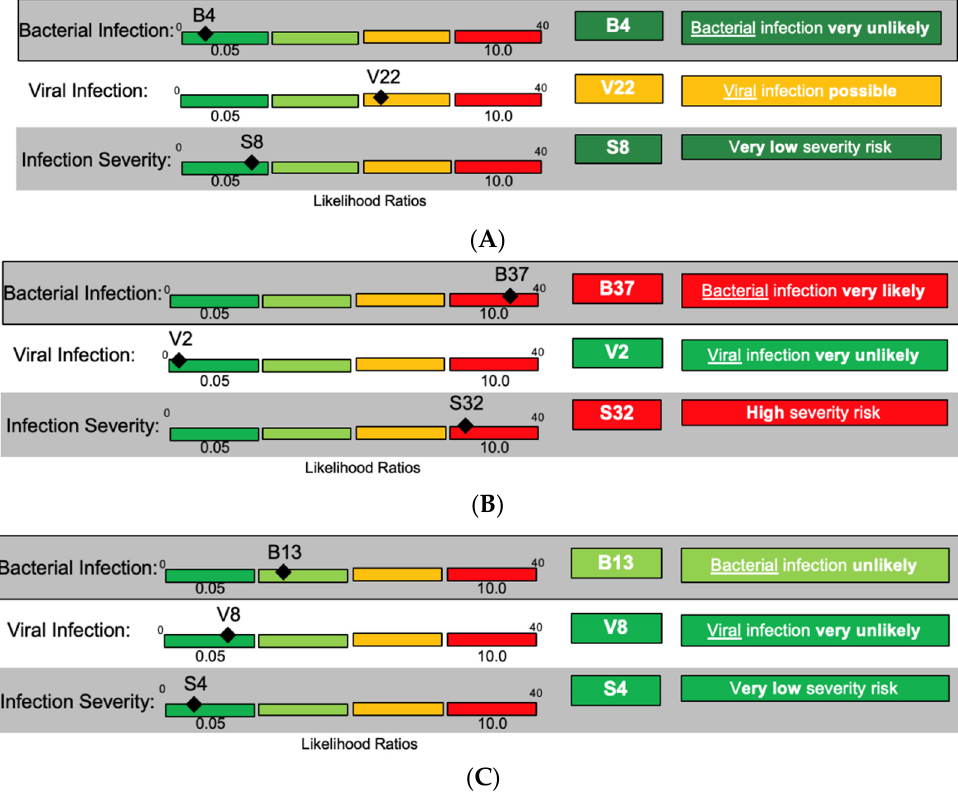
Figure 4. Three hypothetical result readouts ( A – C ) for InSep for the same patient presenting with subjective fever and vital sign changes.